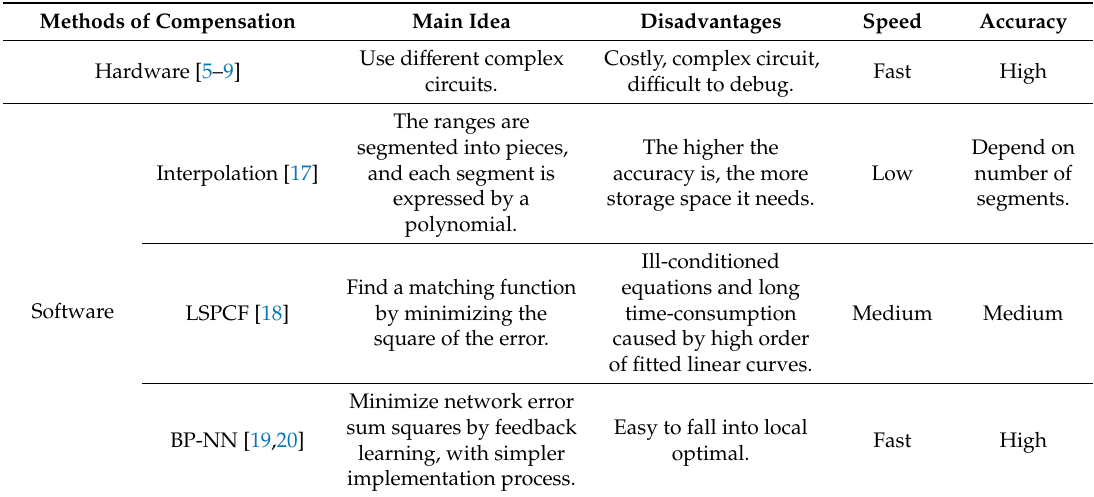
Table 1. Comparison of hardware and software compensation methods for monitoring data in the